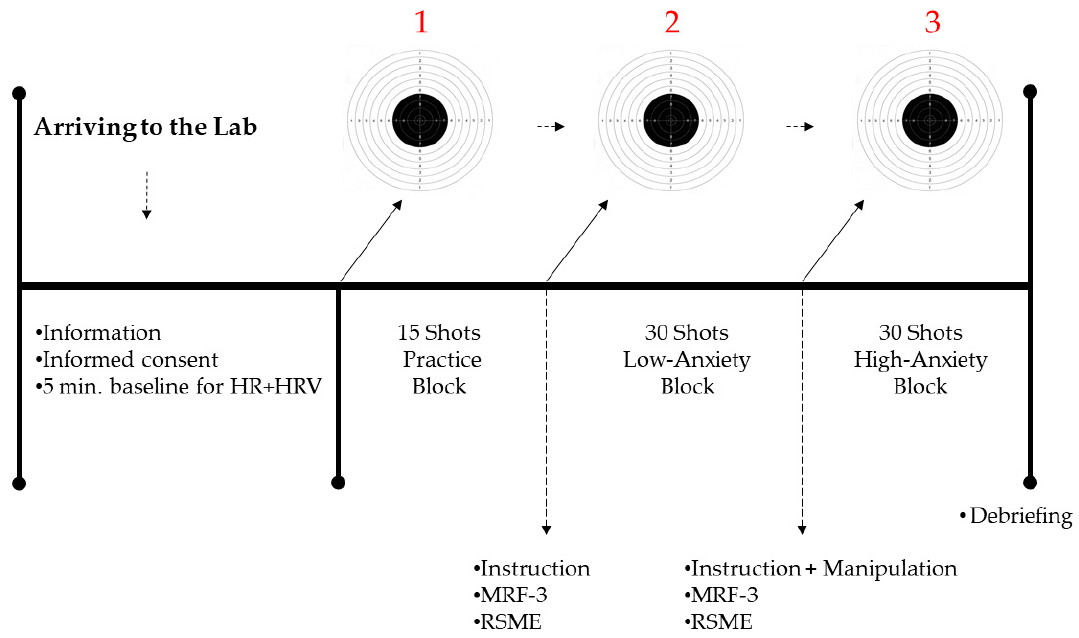
Figure 2. Demonstration of the experimental procedure.